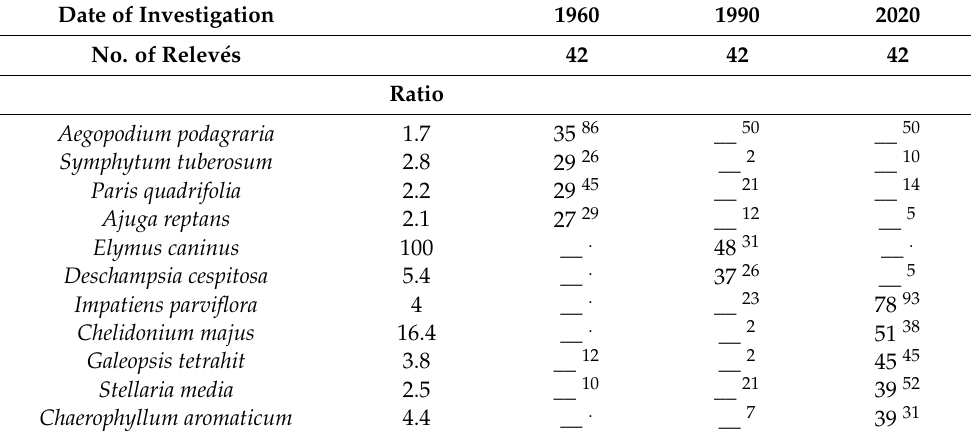
Table 1. Differentiating herbaceous species for the subsequent periods of investigation. Species are ordered according to their diagnostic value in a particular survey. The Φ coefficient values in the table are multiplied by 100. Their superscripts express the percentage values of species frequency. Only species with Φ > 25, frequency > 25, and constancy ratio > 1.5 were included in the table. Sign “__” means that a given species does not reach a statistically significant Φ value in a particular cluster.